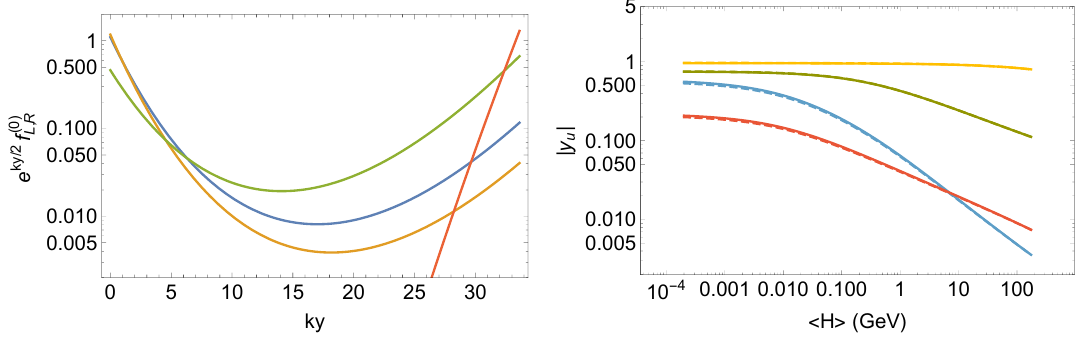
Figure 6 . (a) Pro(cid:12)le along the extra dimension of the left- and right-handed charm (blue and yellow), and the left- and right-handed top (green and red) for the approximation (7.2) to the Goldberger-Wise pro(cid:12)le. (b) Yukawa couplings and the o(cid:11)-diagonal Yukawa couplings ated using the approximation (7.2) to the Goldberger-Wise pro(cid:12)le, whereas for the dashed curves the exact expression (3.4) was